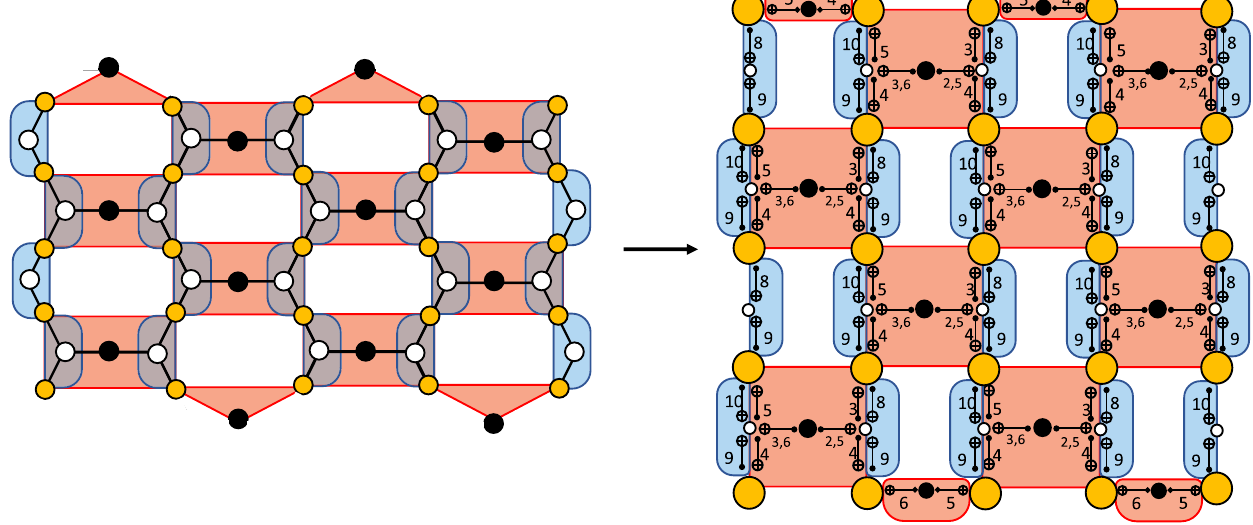
FIG. 2. The left side of the figure corresponds to the actual layout of the d ¼ 5 heavy-hexagon code, which encodes one logical qubit. The data qubits are represented by yellow vertices, white vertices are the flag qubits, and dark vertices represent the ancilla to measure the X -type gauge generators (red areas) and the Z -type gauge generators (blue areas). In the bulk, products of the two Z -type gauge generators at each white face form a Z -type stabilizer. The right side of the figure provides a circuit illustration of the heavy-hexagon code with the scheduling of the CNOT gates used the measure the X -type and Z -type gauge